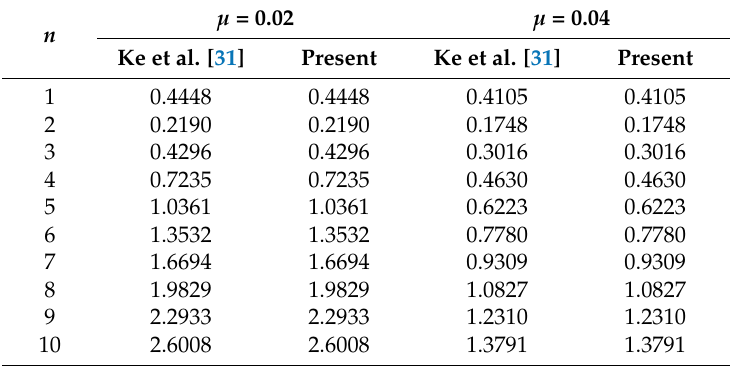
Table 2. Comparison of natural frequency ω (GHz) of a SS-SS homogeneous piezoelectric nanoshell ( µ = e 0 a / L ).